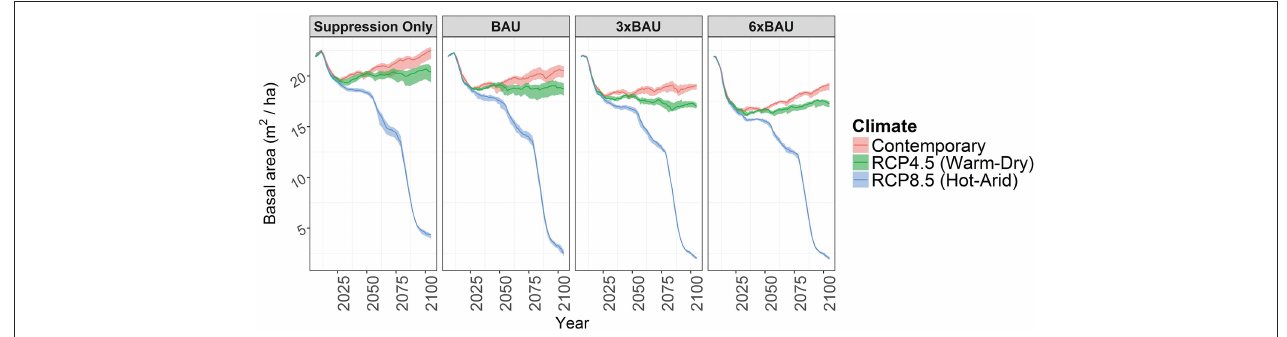
FIGURE 6 | Basal area (m 2 /ha) of ponderosa pine and dry mixed conifer sites for a Ponderosa pine-dominated landscape in the Jemez Mountains, New Mexico, U.S. Scenarios are factorial combinations of management (“business as usual,” BAU; three-fold (3 × BAU) or six-fold (6 × BAU) annual increase in BAU; 90% fire suppression) and climate (Contemporary; Warm-Dry; Hot-Arid). Shaded regions show median (darker line) and 25th and 75th percentiles (lighter shading) among model replicates for each scenario. With Hot-Arid climate, basal area decreased early in the simulation period ca. AD 2025, and by AD 2100 was about 10 percent of its starting amount. Basal area was maintained with Warm-Dry climate and any of the four management factors. Adapted from Loehman et al.